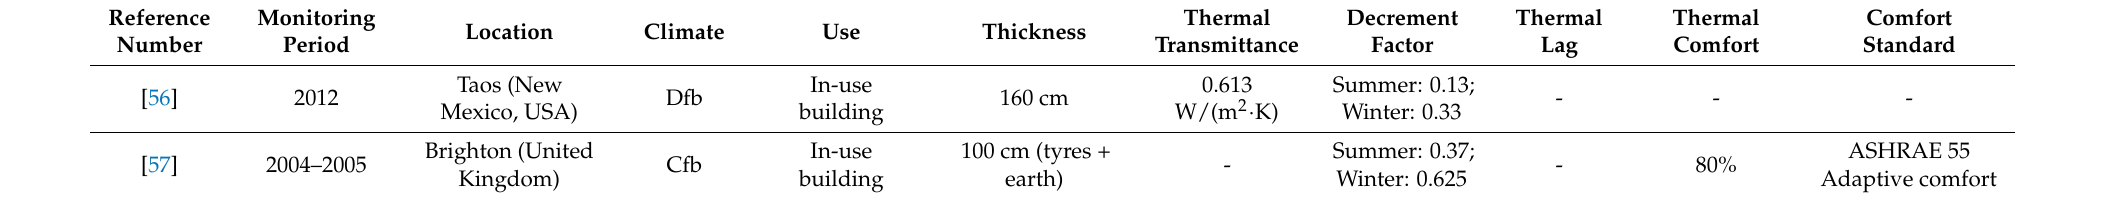
Table 16. Building characteristics and thermal performance of the earthship monitored studies.